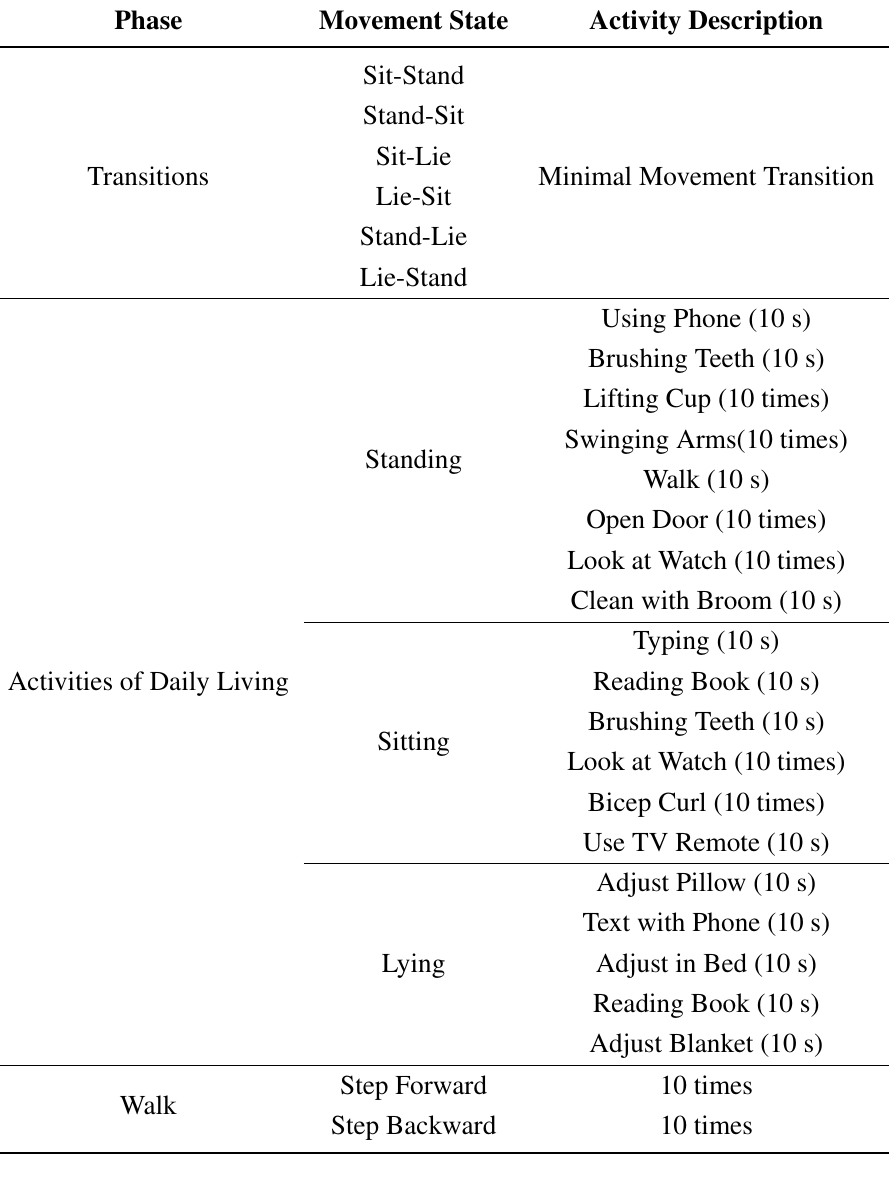
Table 1. Movements